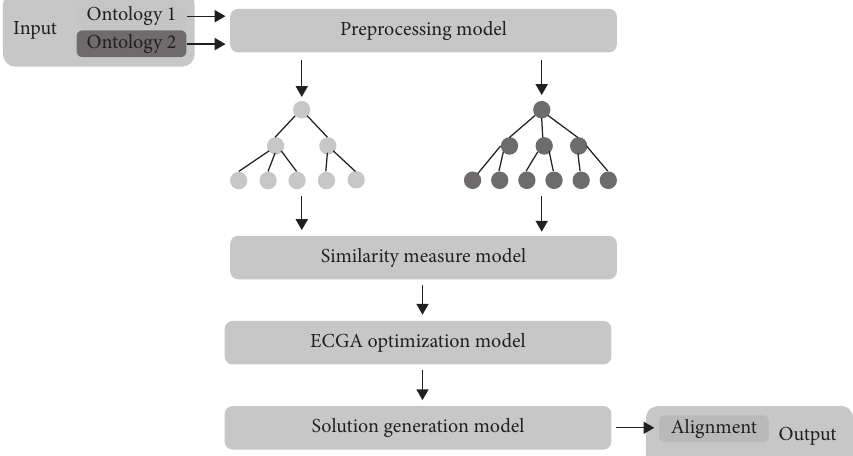
Figure 4: The framework of